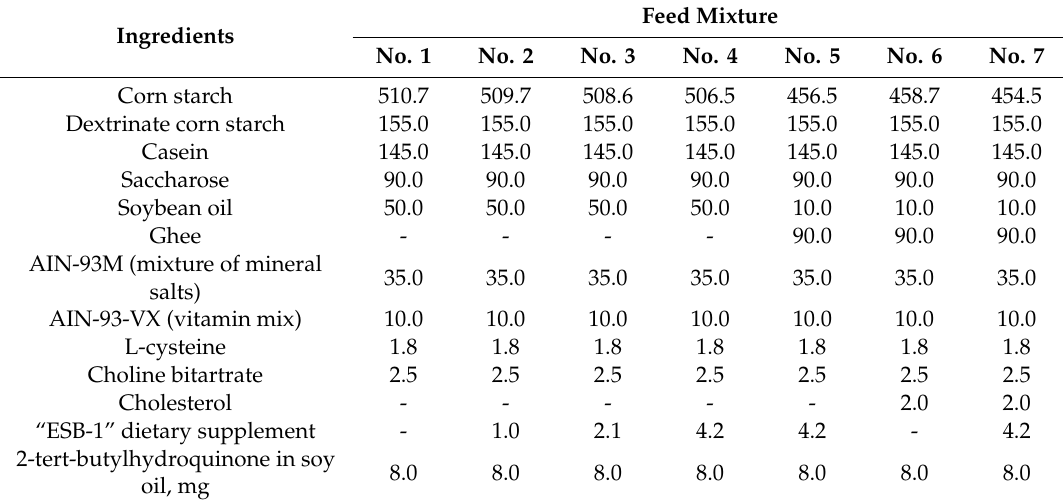
Table 2. Feed mixture recipes (g / kg of